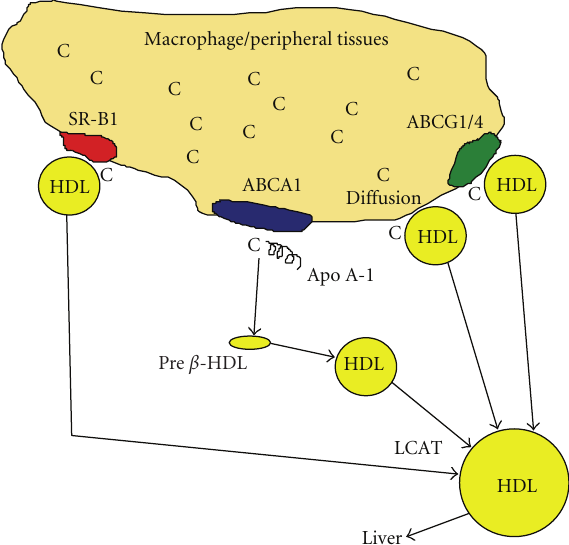
Figure 10: Reverse cholesterol transfer pathway (RCT). RCT is the major pathway for transfer of excess cholesterol (C) from peripheral tissues to the liver for disposal as bile. High levels of cholesterol can be toxic and the accumulation of cholesterol (C) in macrophages lining the blood vessels transforms these cells to foam cells leading to the development of plaque and atherosclerosis. Cholesterol is removed from these tissues and transferred to HDL by interactions with ATP binding cassette receptors ABCA1, ABCG1/4, and SR- B1 or by di ff usion. The interaction between ABCA1 and apo A- I is the dominant pathway for removal of excess cholesterol from macrophages followed by an interaction between HDL and ABCG1. Together these two receptors account for about 70% of the e ffl ux of excess cholesterol [86]. The size of HDL is modulated as its load of cholesterol increases and by interactions with various plasma factors such as lecithin cholesterol acyltransferase (LCAT) [87]. Free cholesterol removed from these tissues is esterified by LCAT and subsequently removed by liver cells by interactions with HDL. SOF enhances this process in several ways [88]. First, it releases free apo A-I, which is a better acceptor of free cholesterol than HDL. Secondly, it forms neo-HDL, a particle that is similar to pre- β HDL, which is also a better acceptor of cholesterol than HDL. Thirdly, SOF enhances cholesterol esterification, which may allow a more e ffi cient uptake of cholesterol by the